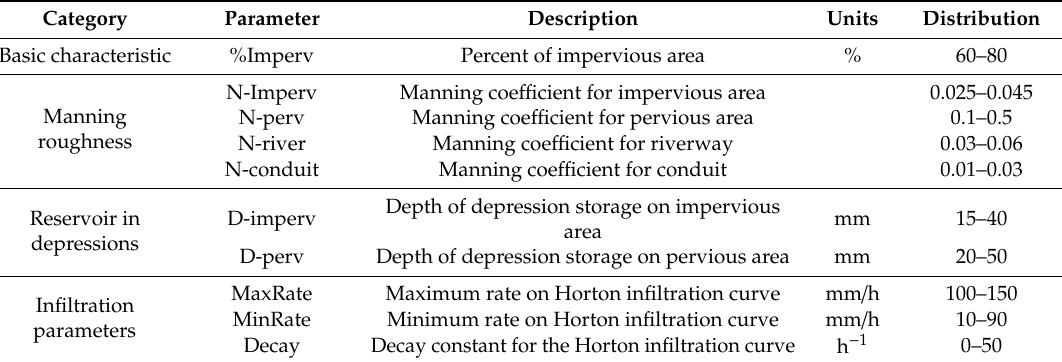
Table 1. Distribution of SWMM parameters.